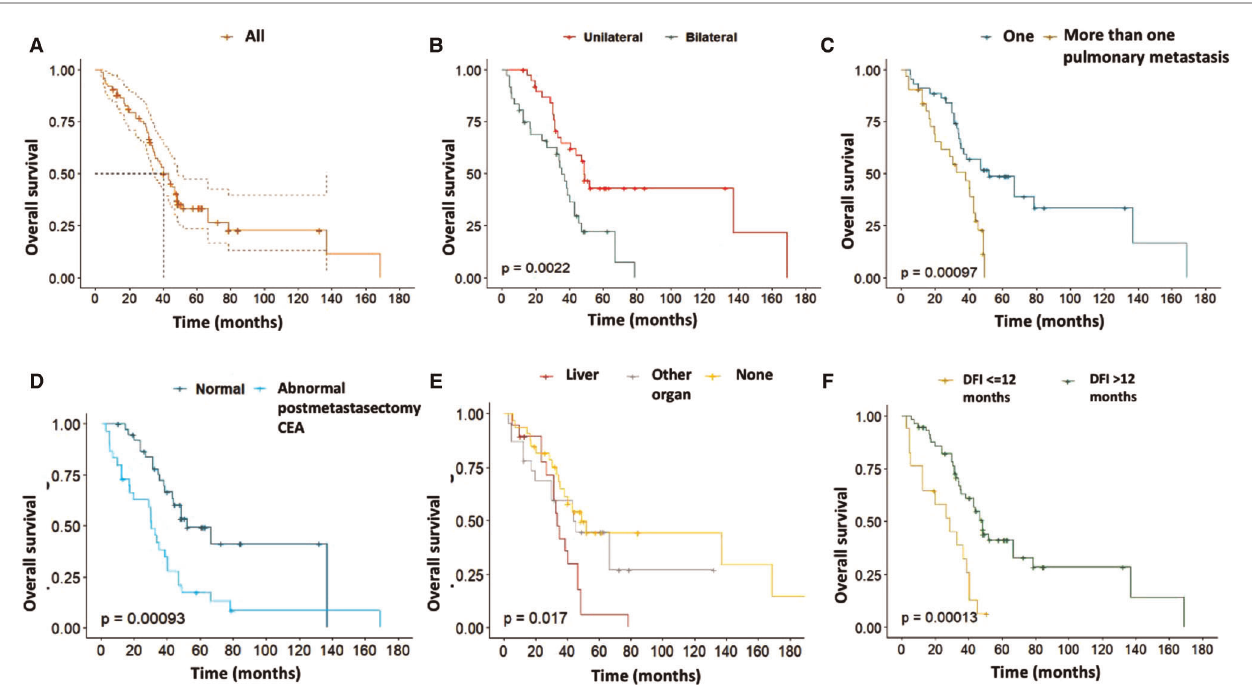
FIGURE 1 | ( A ) Overall survival (OS). ( B ) OS of patients with unilateral and bilateral metastases. ( C ) OS according to the number of pulmonary metastases ( D ) OS of patients with normal and abnormal postmetastasectomy carcinoembryonic antigen ( E ) OS of patients with a history of extrapulmonary metastasis ( F ) OS according to the disease-free interval ≤ 12 and >12 months. Kaplan-Meier curves with the log-rank